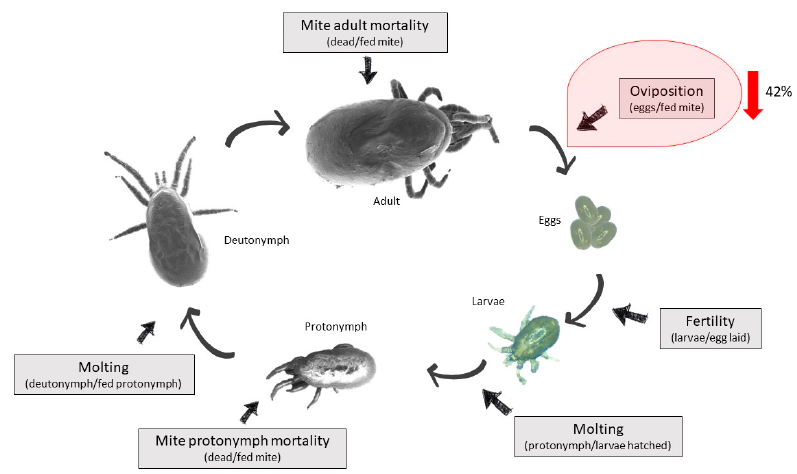
Figure 2. Life cycle of D. gallinae and checkpoints for the evaluation of vaccine efficacy. The SEM images for the hematophagous stages of PRM are shown as a representation of the life cycle. During the on-hen feeding assay, the following parameters were recorded per individual hen: adult mite mortality (number of dead/fed mites), oviposition (number of eggs laid/fed mite), fertility (number of larvae/eggs laid), larvae molting (number of protonymphs/larvae hatched), protonymph mortality (number of dead/fed protonymphs), and protonymphs molting (number of deutonymphs/protonymphs). The results showed a 42% reduction in oviposition (GLMM; F = 6.06, p = 0.014, gl1 = 1, gl2 = 747) of mites fed on vaccinated hens when compared to